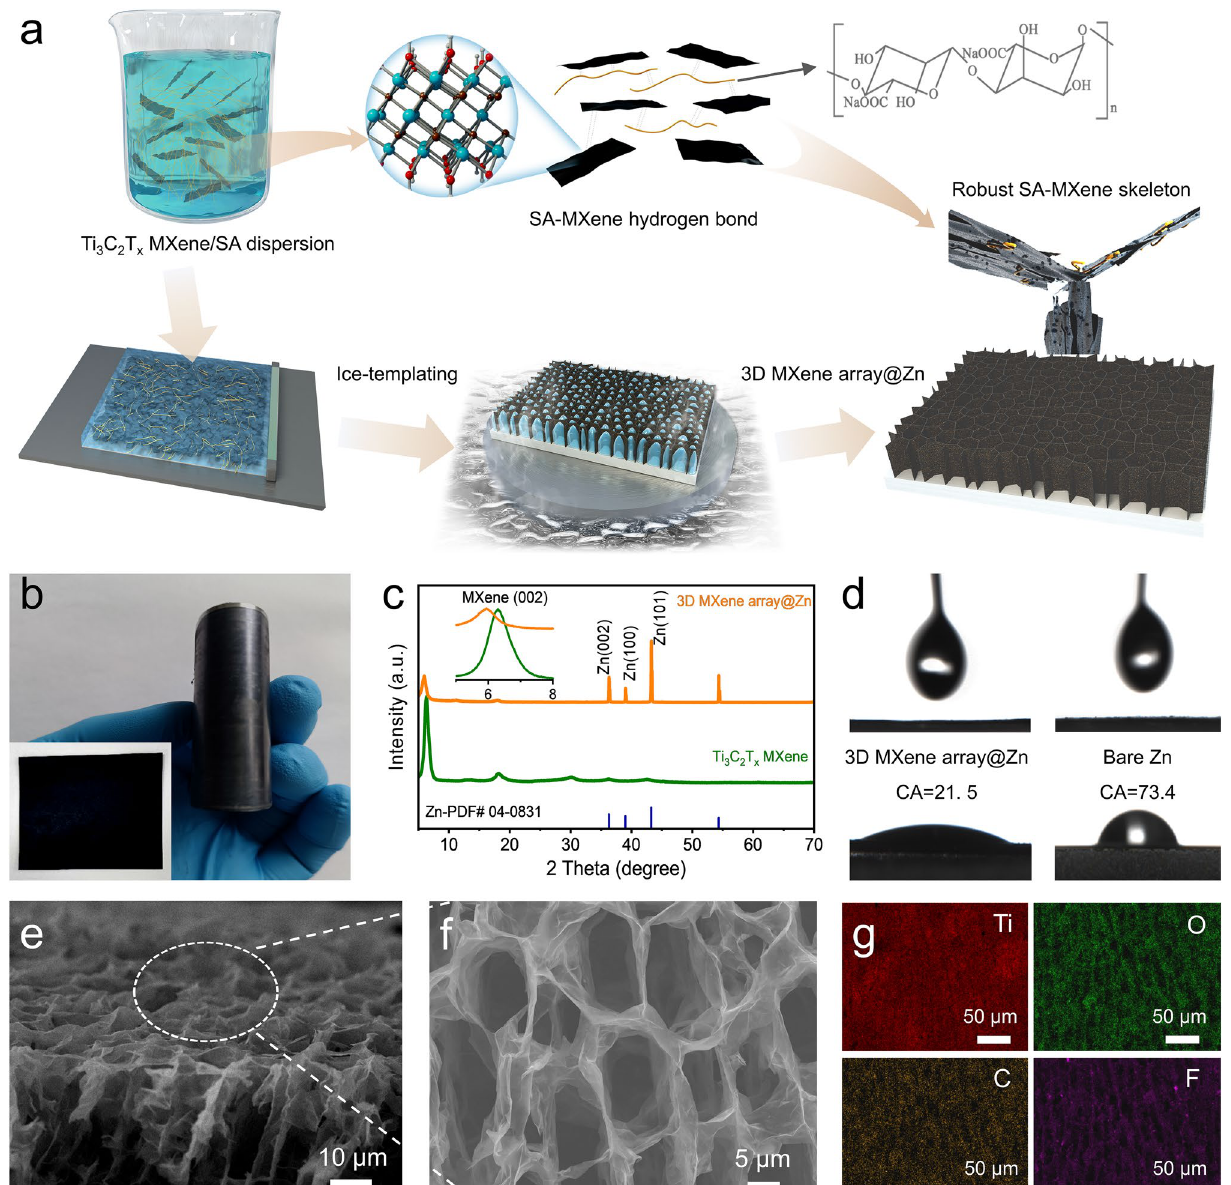
Fig. 1 a Schematic illustration of the fabrication process of 3D MXene array@Zn. b Optical image of 3D MXene array@Zn foil. c XRD pat- terns of the Ti 3 C 2 T x MXene and 3D MXene array@Zn. d The contact angle of 3 M Zn(CF 3 SO 3 ) 2 against 3D MXene array@Zn and pure Zn foil. e Side-view and f top-view FESEM images of 3D MXene array@Zn foil, and g corresponding EDS